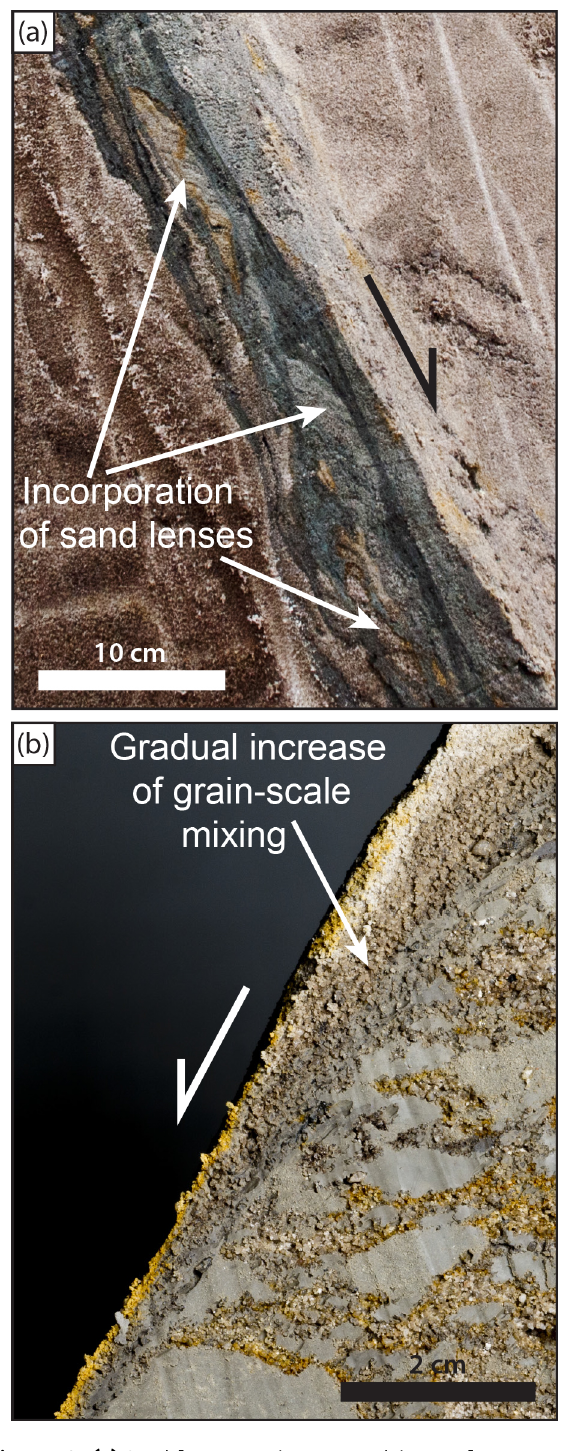
Figure 19. (a) Sand lenses are incorporated into a clay smear by grain-scale mixing and lead to increasing thickness of the clay rich fault material. (b) A layer of loosely packed rip-up clasts embed- ded in sand forms a continuous clay smear by grain-scale mixing. Due to the close spacing of sand and clay, grains are mixed imme- diately during shearing. Note how the sand content increases with increasing distance to the source